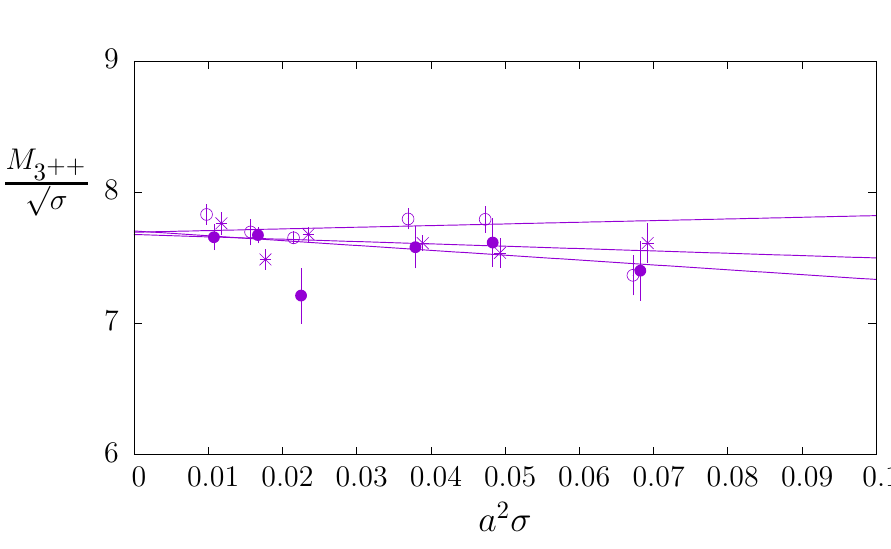
Figure 14 . Continuum extrapolation of the lightest J PC = 3 ++ glueball. Obtained from the lightest A 2 ++ state ( • ), the lightest T 1 ++ state ( ◦ , triply degenerate) and the third excited T 2 ++ states ( ? , triply degenerate): hence the seven components of the J = 3 ground